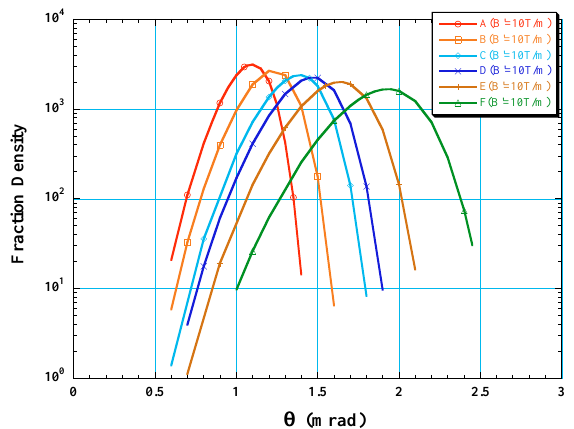
FIG. 7. (Color) Angular distribution of proton beams formed by Lorentz stripping in a magnetic-field gradient through H (cid:48) ( (cid:110) (cid:173) (cid:51) ) Stark states. (cid:84) (cid:173) (cid:50)(cid:46)(cid:53) GeV.